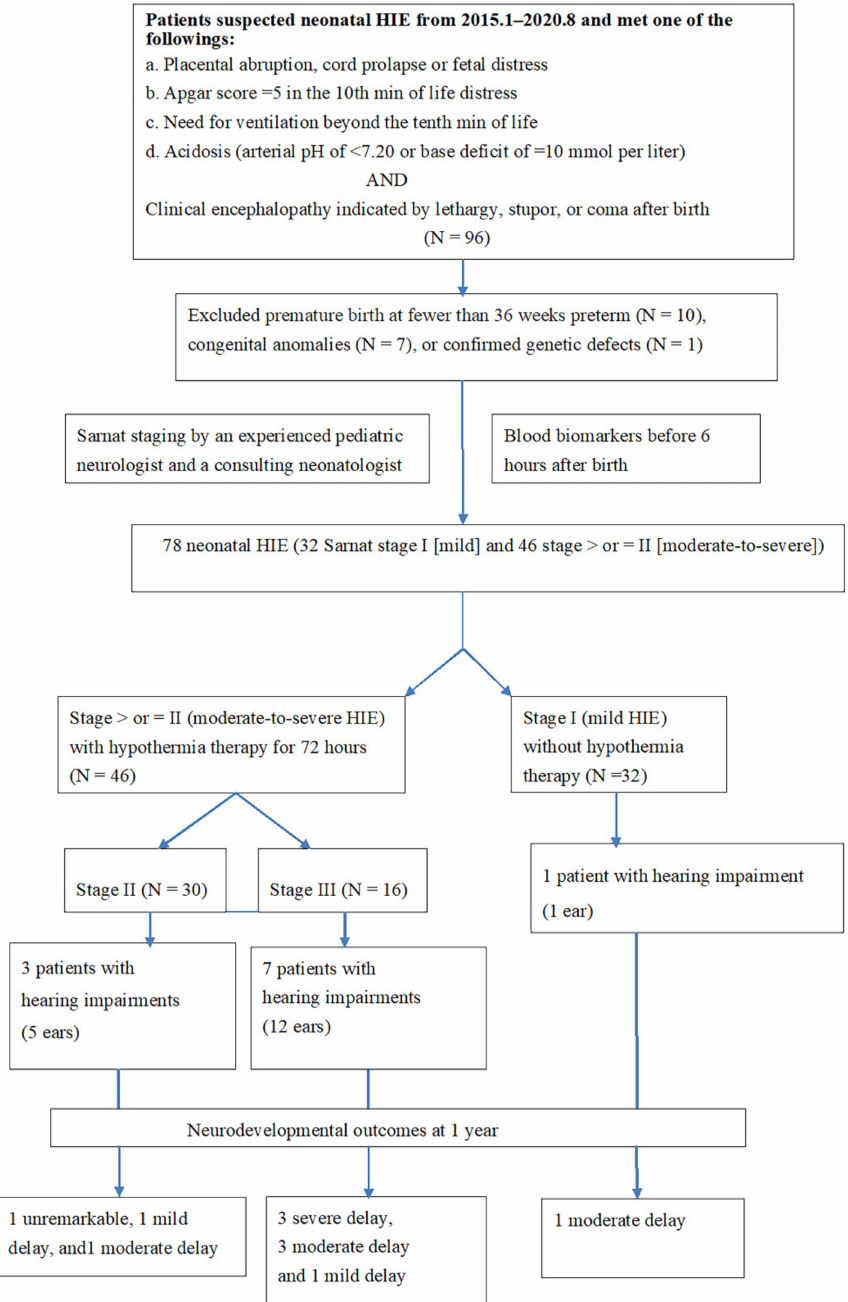
Figure 1. Flowchart of the study procedure for patients with neonatal hypoxic–ischemic encephalopa- thy and hearing